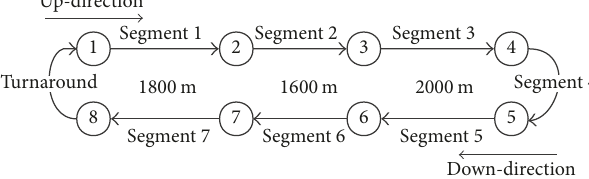
Figure 5: Representation of a short metro line.